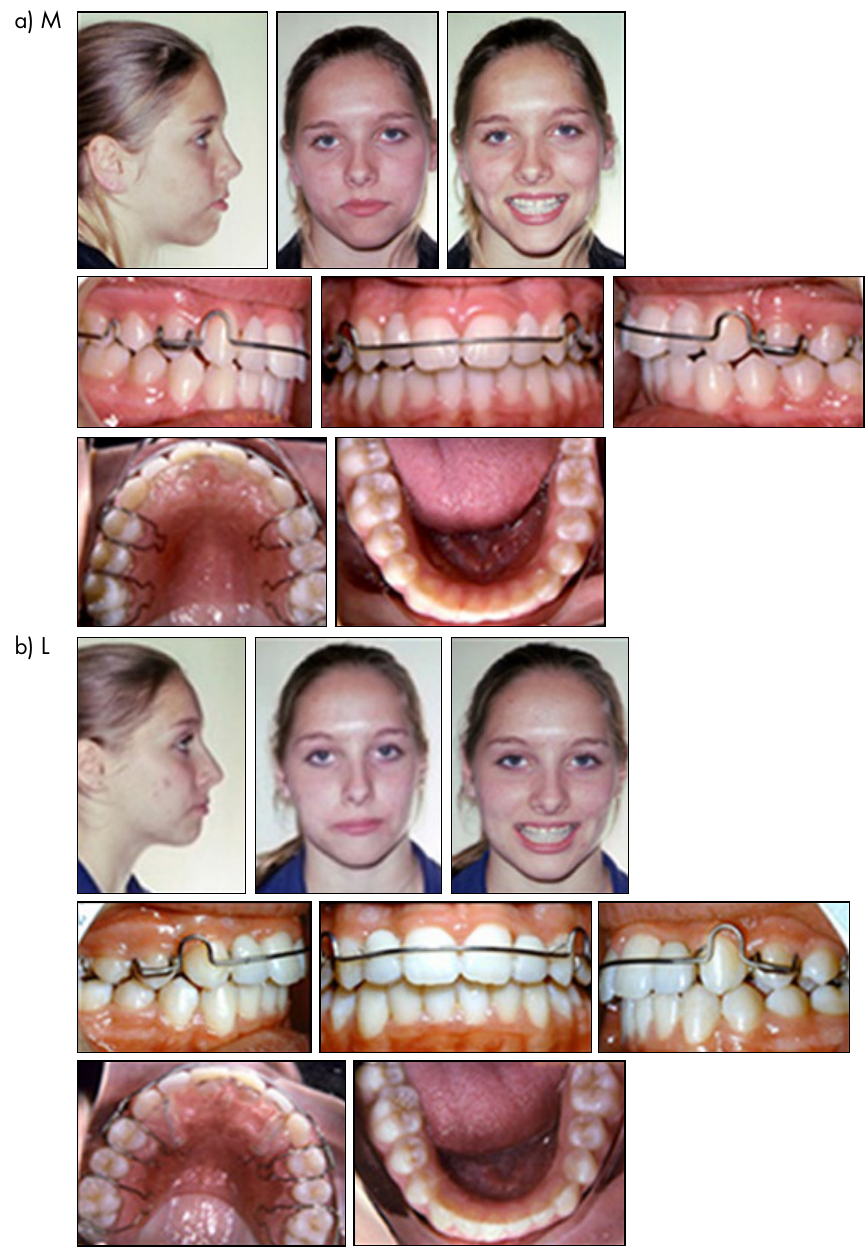
Figure 9. Post-treatment facial and intraoral photographs with pontics on removable retainers (age 14Y